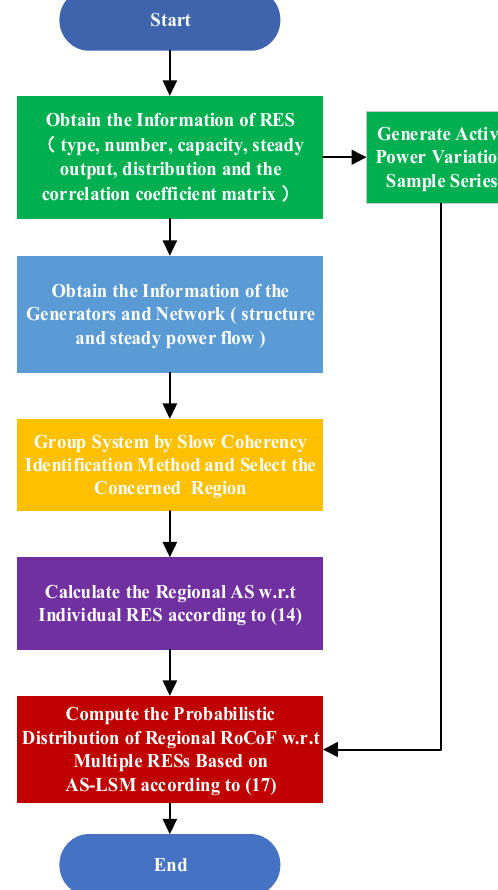
Figure 3. Flowchart of the calculation procedure for probabilistic distribution of regional rate of change of frequency (RoCoF) by analytical sensitivity-linear sensitivity-based method (AS-LSM).